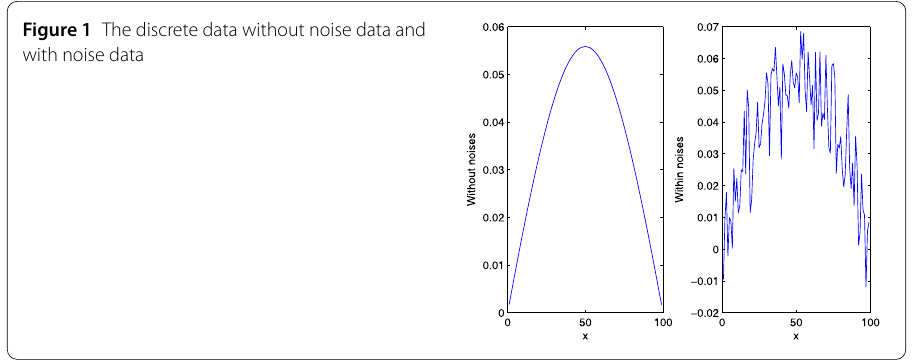
Figure 1 The discrete data without noise data and with noise